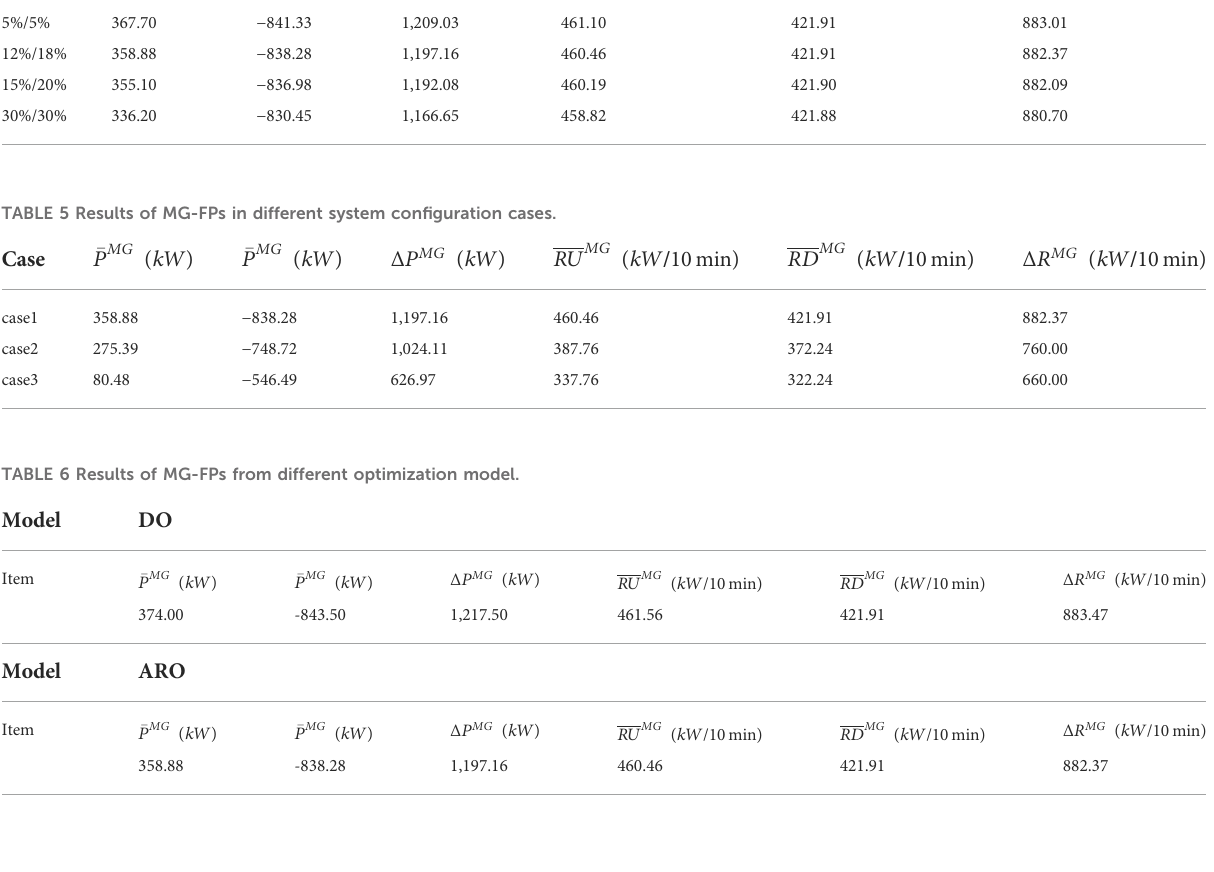
TABLE 7 System operation performance with MG-FPs from different optimization model. Prediction error